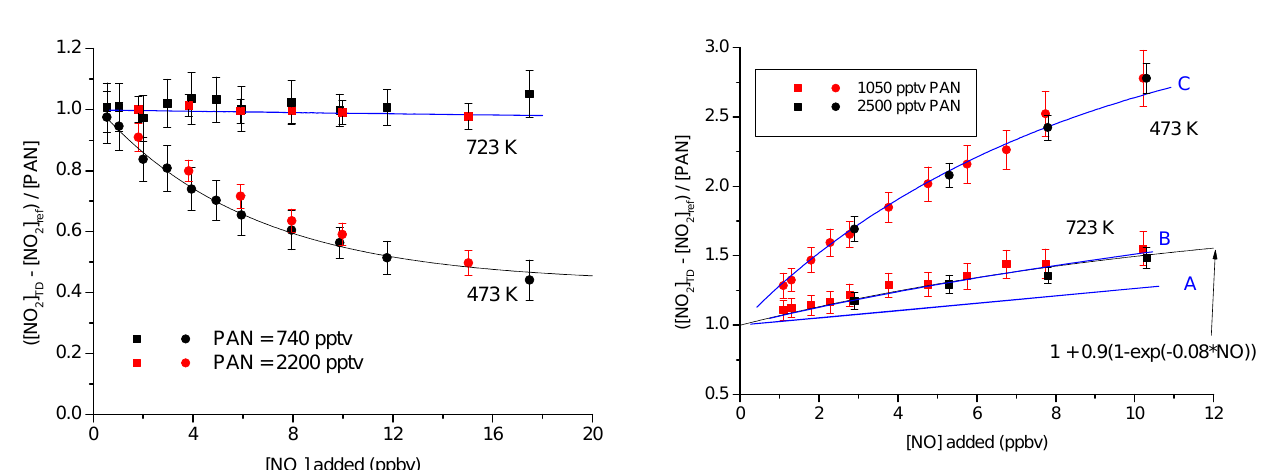
Figure 10. Measurements of the difference signal (TD cavity sam- pling from the 473 (squares) or 723K inlet (circles) – NO 2 ref- erence cavity) when adding various amounts of NO to PAN sam- ples (1000 or 2500pptv). [NO 2 ] TD refers to the mixing ratio of NO 2 measured in the TD cavity sampling from either the 473 or 723K inlet. The simulations (blue lines) labelled A and B are model predictions of the effect of adding NO 2 to the 723K inlets using different rate constants for the rearrangement of CH 3 C(O)O 2 to CH 2 C(O)OH (see text for details). The simulation labelled C cor- responds to the 473K inlet. The error bars represent standard devi- ation and were derived by propagating errors in the NO 2 signals in the TD and reference cavities. The black lines show exponential fits to the data as described by the expressions